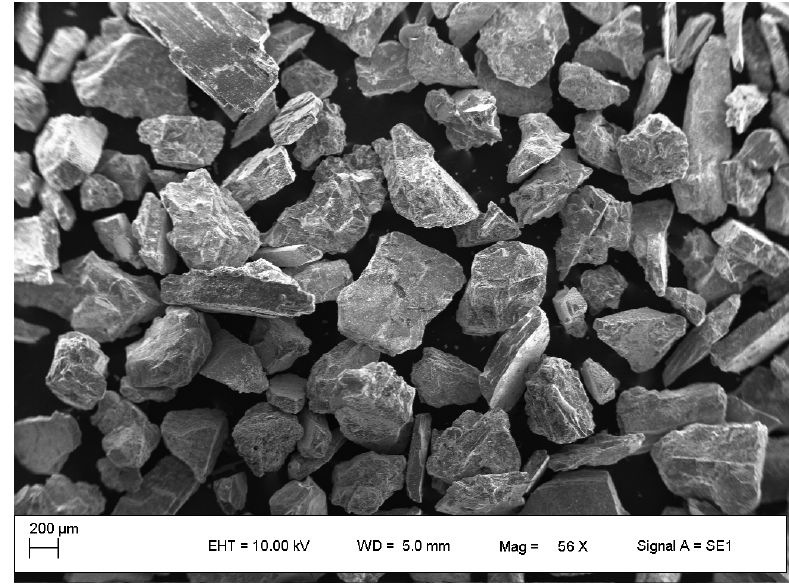
Figure 3. SEM image showing the abrasive particles’ shape and size (56 ×